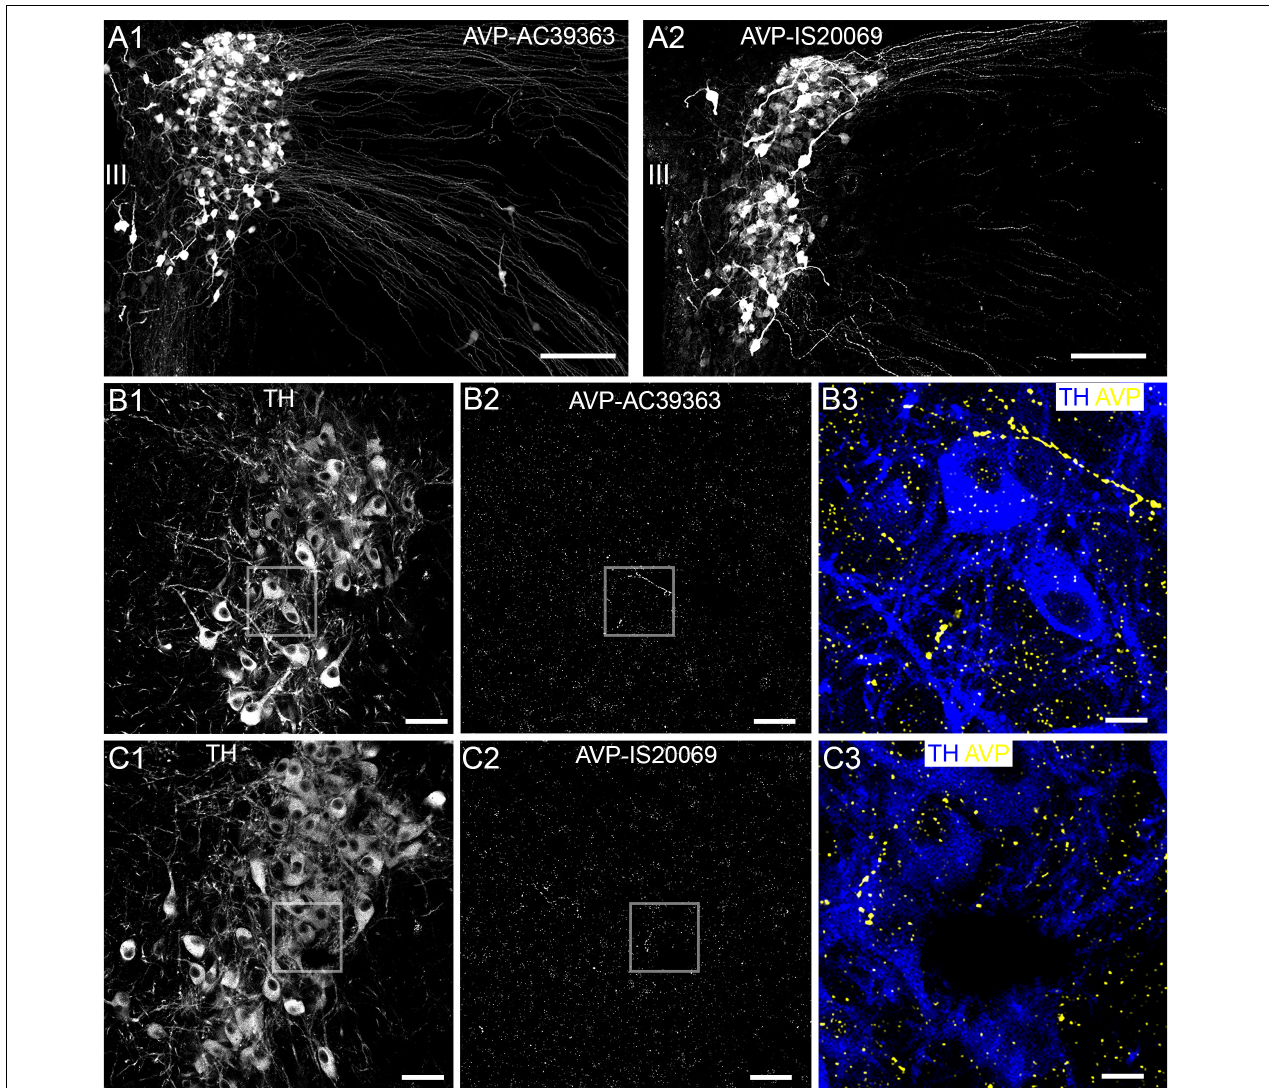
FIGURE 6 | Confirmation of AVP immunoreactivity, in the hypothalamus and LC. (A1,A2) Show the comparative immunoreactivity patterns of two different AVP antibodies, in the paraventricular nucleus of the hypothalamus. AC39363 is the antibody obtained from Abcam and IS20069 is the antibody obtained from ImmunoStar, with further details provided in Supplementary Table S1 . Both antibodies replicate the characteristic pattern of AVP expression expected in this brain region (Zhang and Hernandez, 2013). (B,C) Show the comparative labeling patterns of these AVP antibodies in the LC, when used under conditions identical to those for hypothalamic tissue. (B3,C3) Shows that within the LC, AVP immunoreactivity presented as a combination of varicose plexuses and individual clusters contacting somatodendritic surfaces. Scale bars (A) 100 µ m; (B1,B2,C1,C2) 50 µ m; (B3,C3) 10 µ m. III, third ventricle.